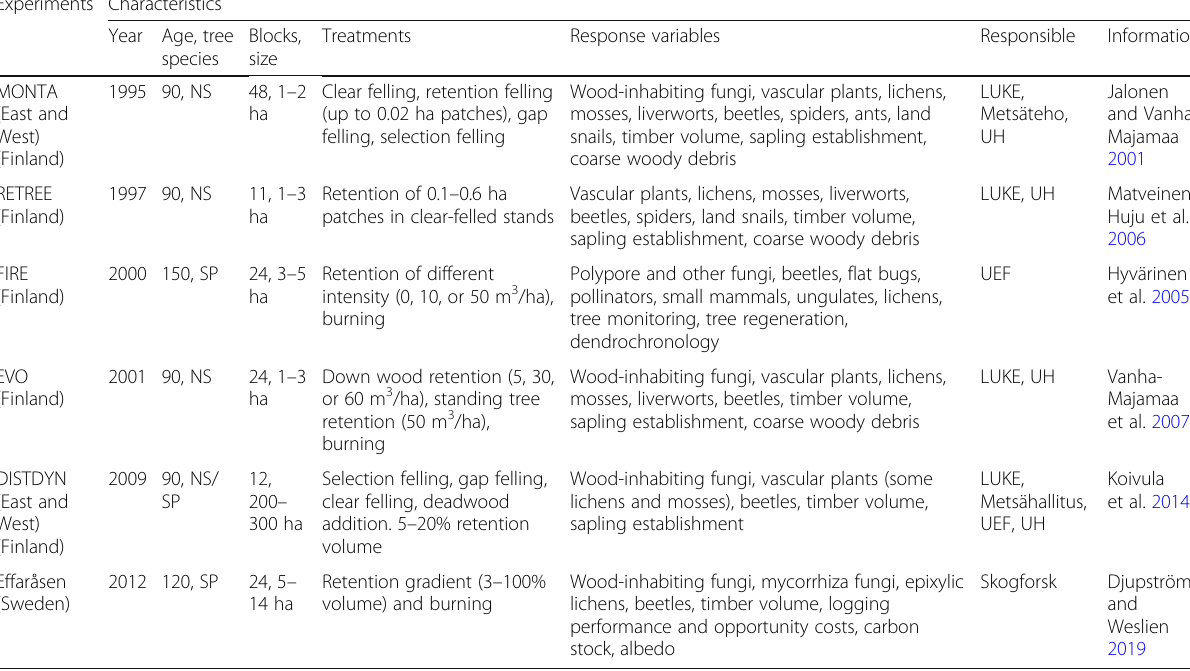
Table 2 Experiments on retention forestry in Finland and Sweden. The Finnish experiments are located in the middle boreal biome and the Swedish experiment in the north boreal biome (Ahti et al. 1968). The Finnish experiments are ordered according to establishment year. For location of experiments, see Fig. 2, and for photos from a selection of experiments, see Fig. 3. Year establishment year, Age stand age at establishment (year), NS Norway spruce Picea abies , SP Scots pine Pinus sylvestris . Blocks, size = number of blocks or stands, and their size ranges. LUKE Natural Resources Institute Finland, Metsähallitus Finnish forest and park services, Metsäteho Metsäteho Ltd., a research and development company by Finnish forest industry organizations, UEF University of Eastern Finland, UH University of Helsinki, Skogforsk Forestry Research Institute of Sweden. For explanation of Finnish experiment names, see the section “ Abbreviations ” in the